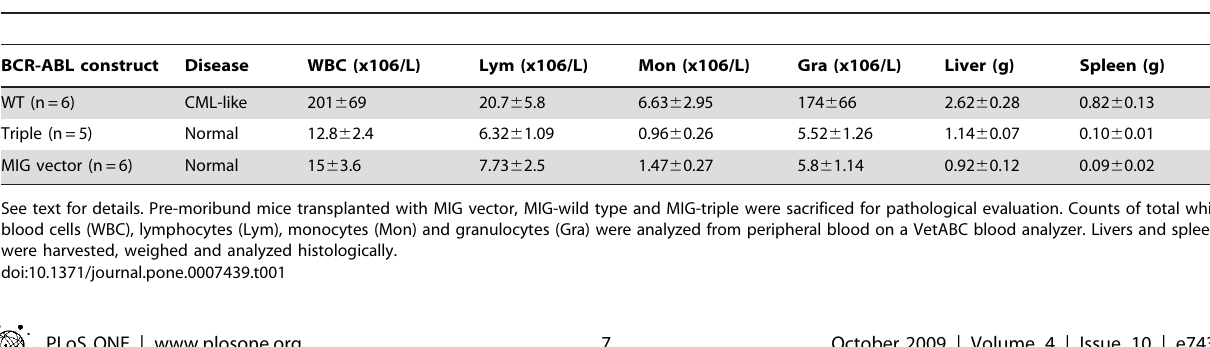
Table 1. Clinical characteristics of mice transplanted with MIG vector, MIG-WT and MIG-triple mutant.